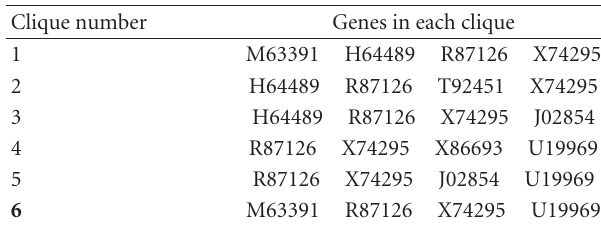
Table 2: Genes accession numbers in each clique identified by MIClique from colon